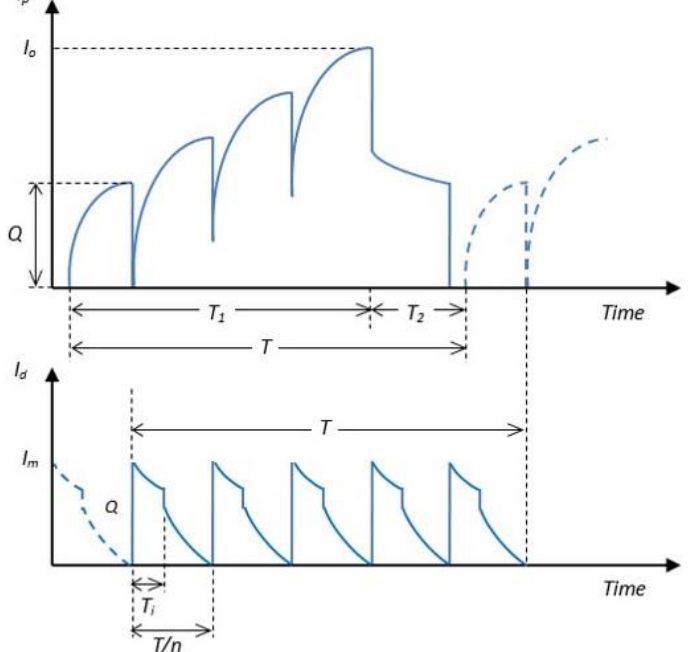
Figure 4. Manufacturer’s and retailer’s inventory model for constantly deteriorating items with retailer’s inspection for n = 5.